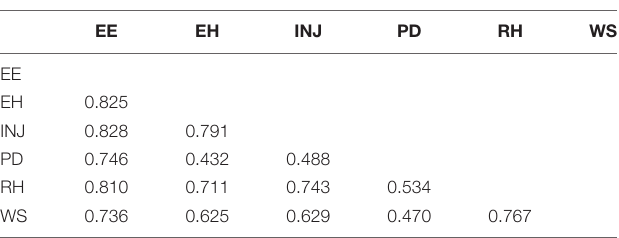
TABLE 4 | Discriminant validity (HTMT ratio). TABLE 5 | Discriminant validity (Fronell and Larcker